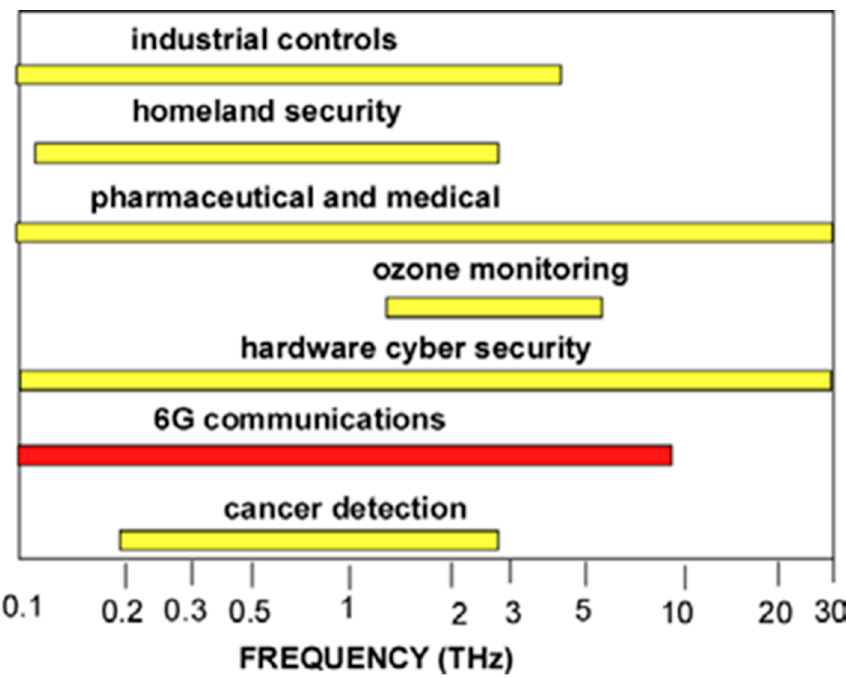
Figure 11. THz frequency ranges for different applications.